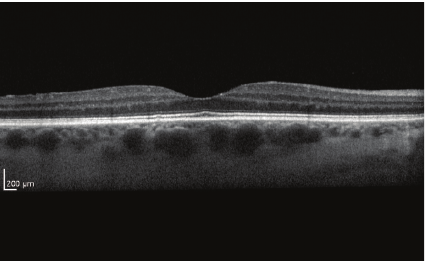
Figure 2: Enhanced depth imaging optical coherence tomography image of right eye showing normal macular anatomy with choroidal thickness of 340 𝜇